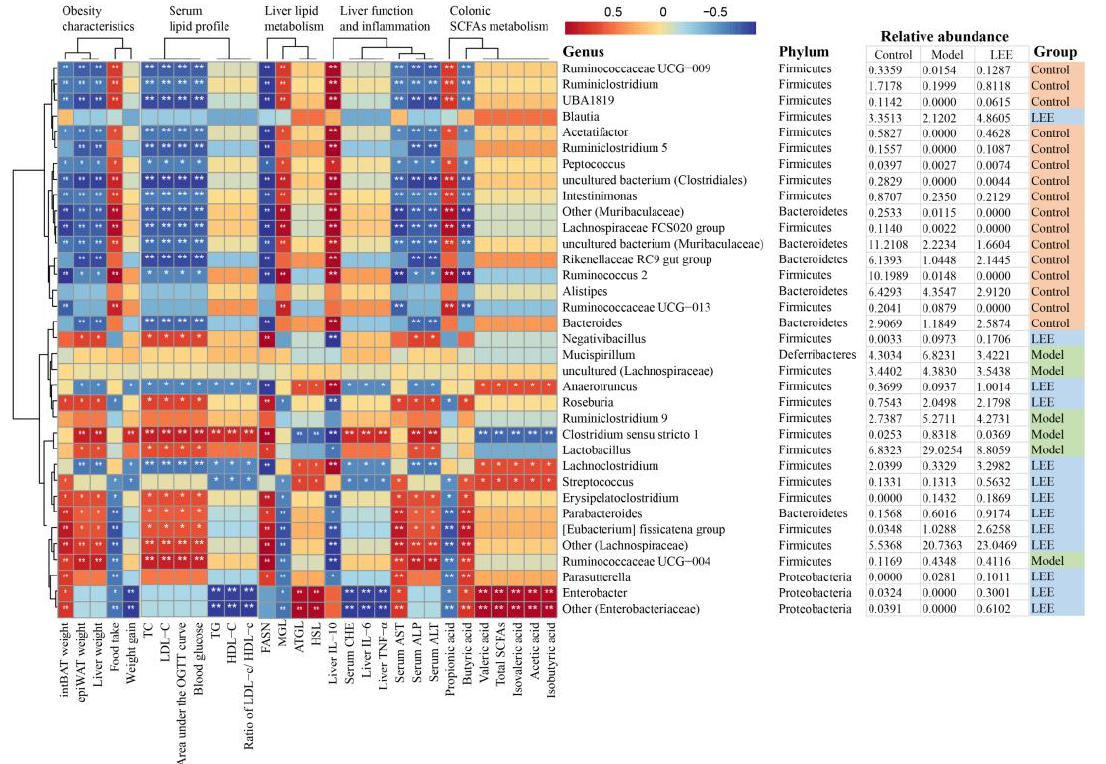
Figure 9. Heatmap of Spearman’s correlation between microbiota markers and liver fat accumulation-related indexes in mice altered by HFD or LEE intervention. A total of 30 microbiota markers were significantly correlated at least with one of the parameters including intBAT weight, epiWAT weight, liver weight, food intake, weight gain, TC, LDL-C, area under the OGTT curve, blood glucose, TG, HDL-C, ratio of LDL-c/ HDL-c, mRNA expression of FASN, MGL, ATGL, and HSL, liver IL-10, IL-6, and TNF- α , serum CHE, AST, ALP, and ALT, colonic digesta propionic acid concentration, butyric acid concentration, valeric acid concentration, total SCFA concentration, isovaleric, acetic and isobutyric acid concentration. The strength of the red/blue hues reflects the degree of association (blue denotes negative correlation and red denotes positive correlation). * p < 0.05, ** p < 0.01. Details (genus, phylum, and relative abundance) of the microbiota markers are shown on the right.